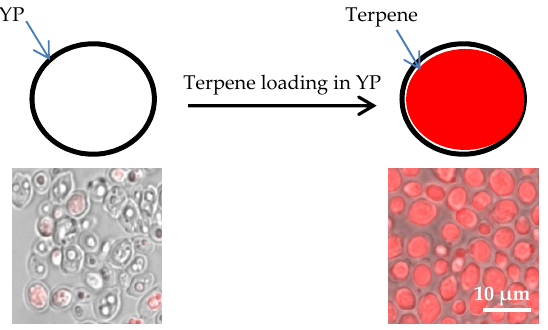
Figure 1. Schematic of diffusion-controlled terpene loading in yeast particles (YPs) and micrographs of samples stained with Nile red, showing empty YPs and YPs loaded with terpene (citral).